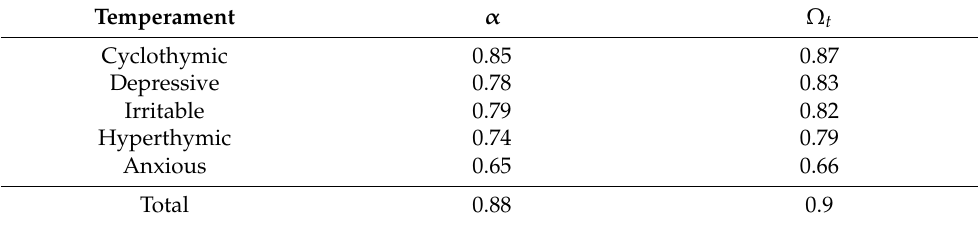
Table 2. Results of the Cronbach’s alpha and McDonald’s omega reliability analyses.